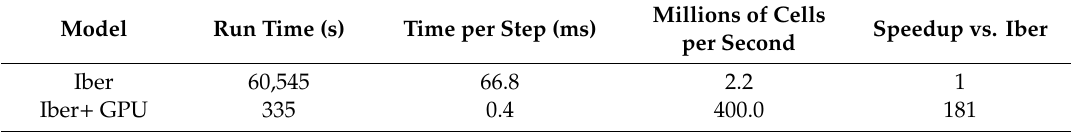
Table 1. Performance measurements obtained for the first test case (estuary of Ferrol).